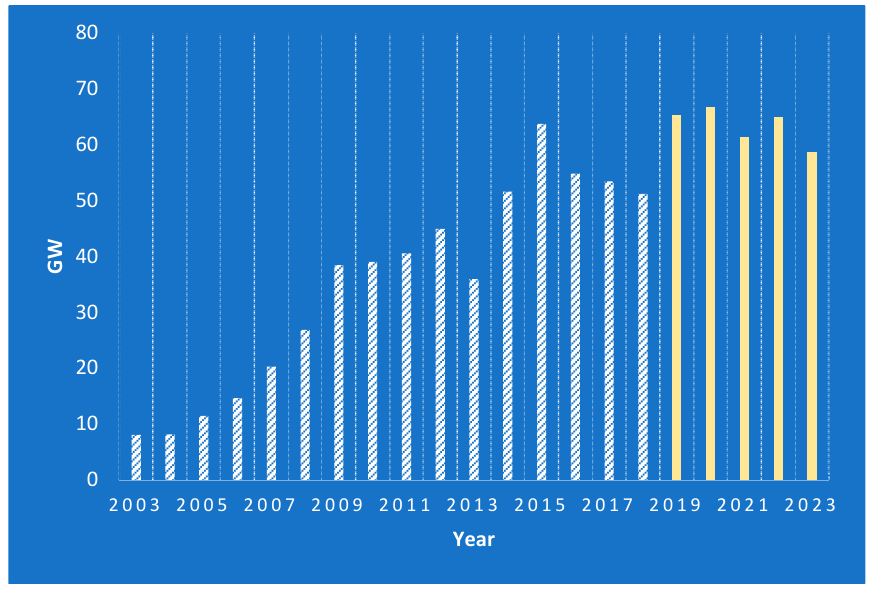
Figure 1. Wind energy capacity and projection. Data from Council, G.W.E. Global wind report [2].